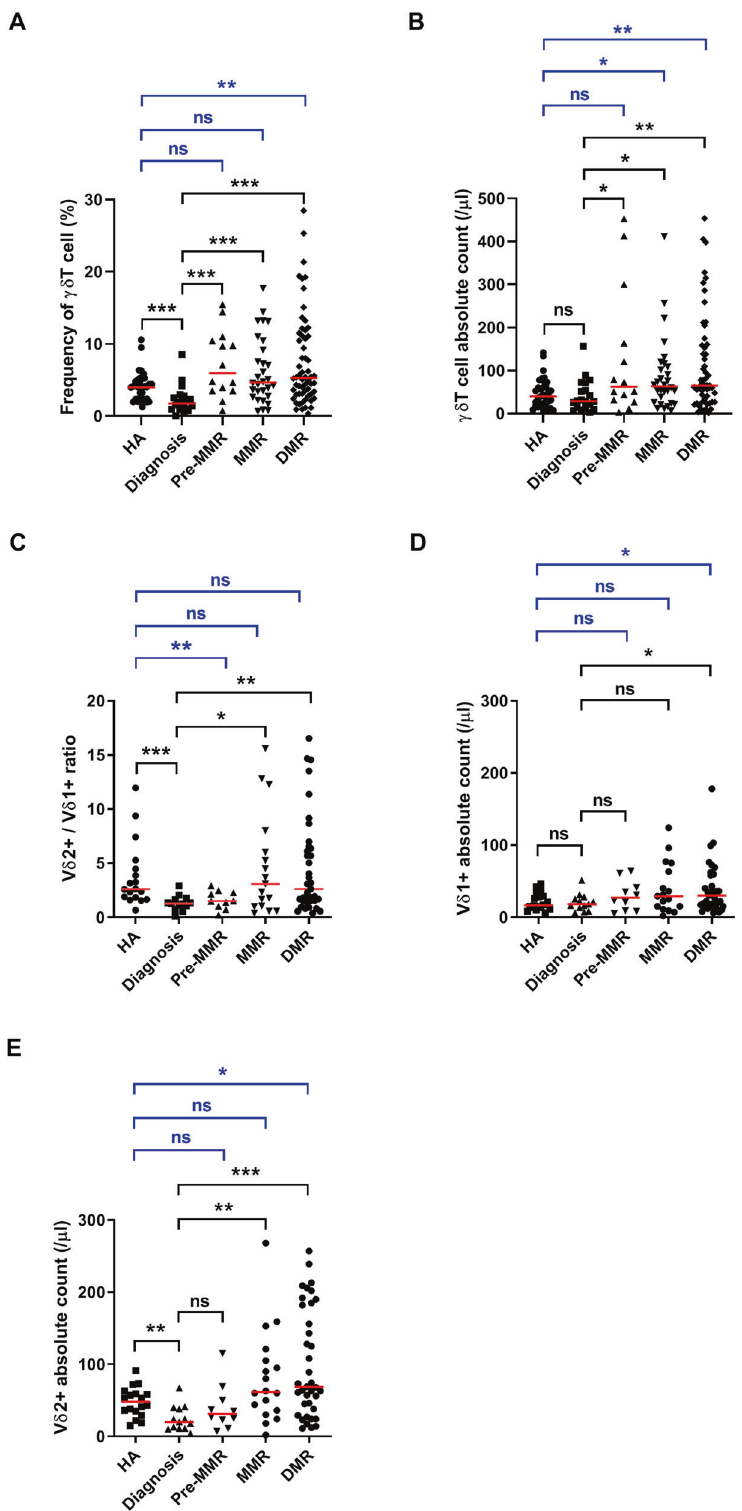
Fig. 1 Expression of γδ T cells and subsets in CML patients at diagnosis (untreated), pre-MMR, MMR, and DMR and in healthy adults (HA). A The percentages of TCR γδ -positive T cells were analyzed from total CD3 + T cells in the PB of CML patients and age-matched healthy adults (HA). B The absolute cell number in PB was enumerated per μ L lymphocytes. C The ratio of V δ 2 to V δ 1 was calculated using the absolute number of γδ T subsets. D – E The number of V δ 1 + and V δ 2 + T cells was measured in patients at different disease states and in healthy subjects. Statistical signi fi cance was assessed by the Mann – Whitney U test. Median values were indicated by the short horizontal red bars. Statistical signi fi cance was de fi ned as * p < 0.05, ** p < 0.01, and *** p <